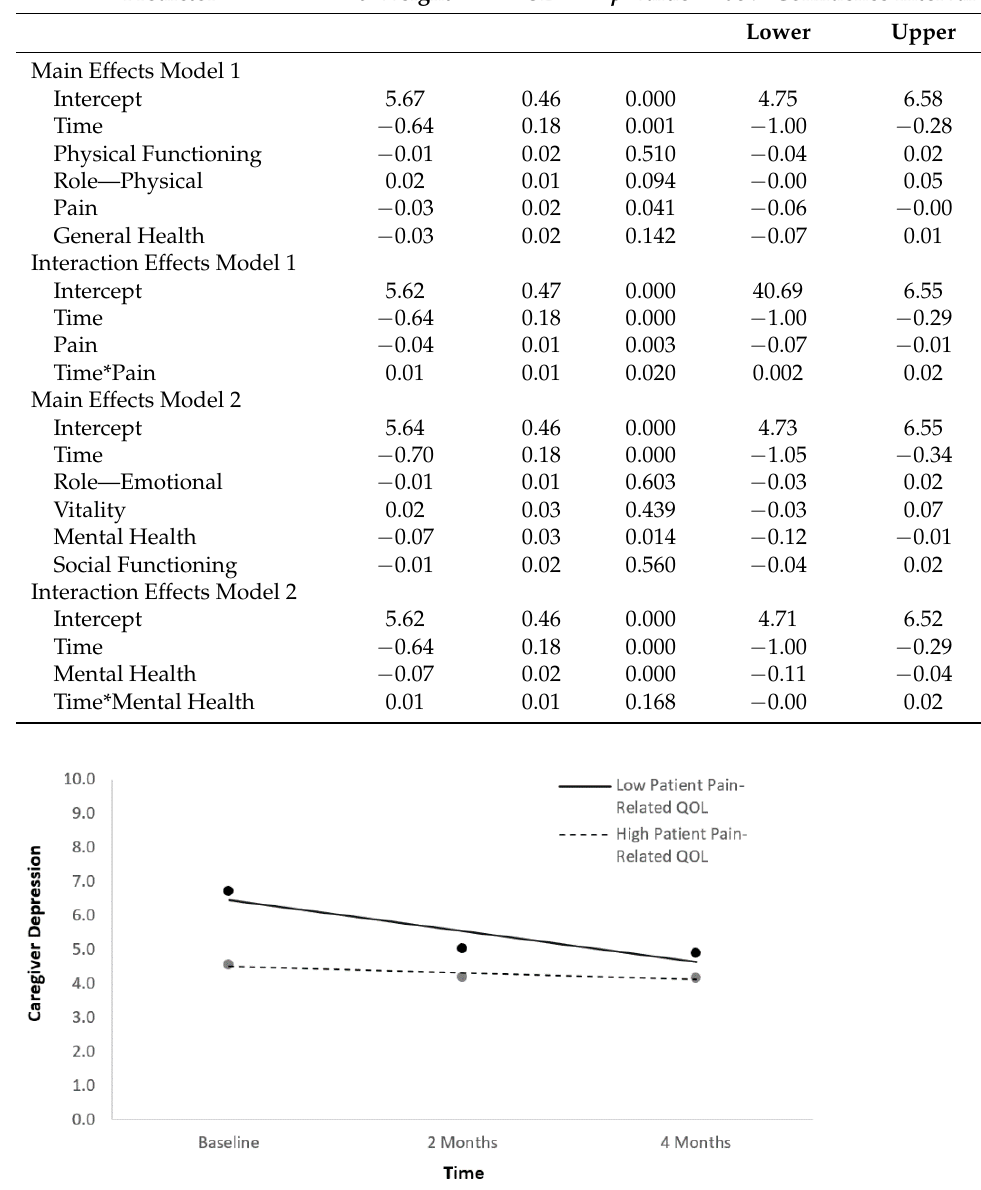
Figure 1. Caregiver depression symptom trajectories as a function of patient pain-related quality of life.